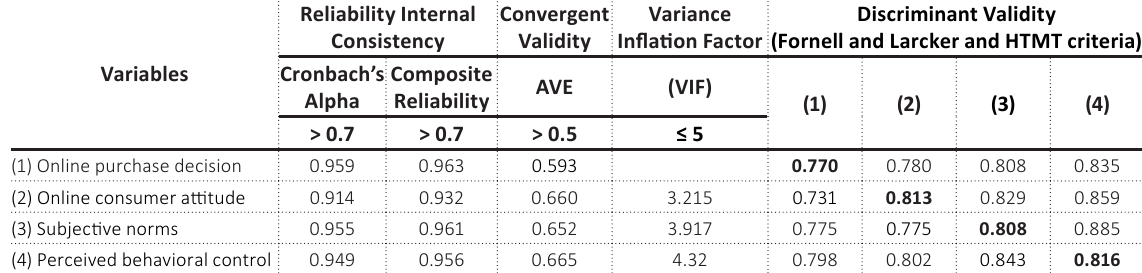
Table 2. Evaluation of the measurement model